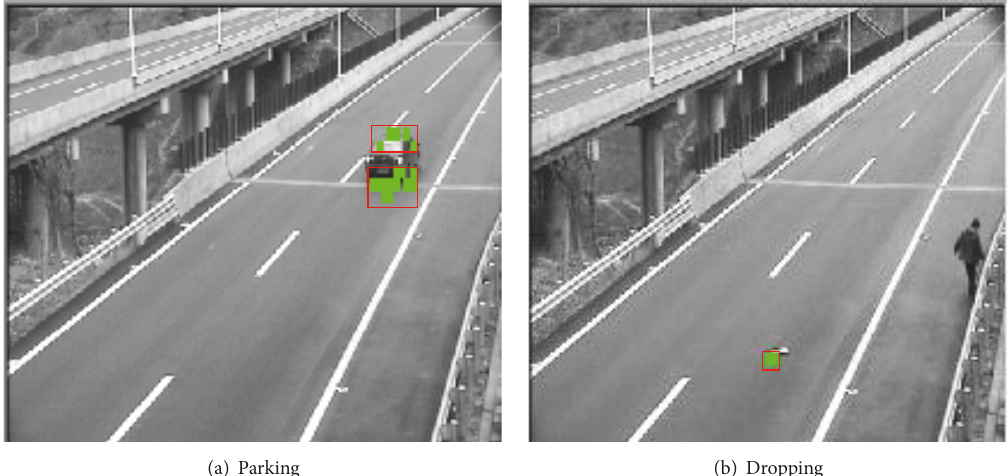
Figure 26: Results of connected domain